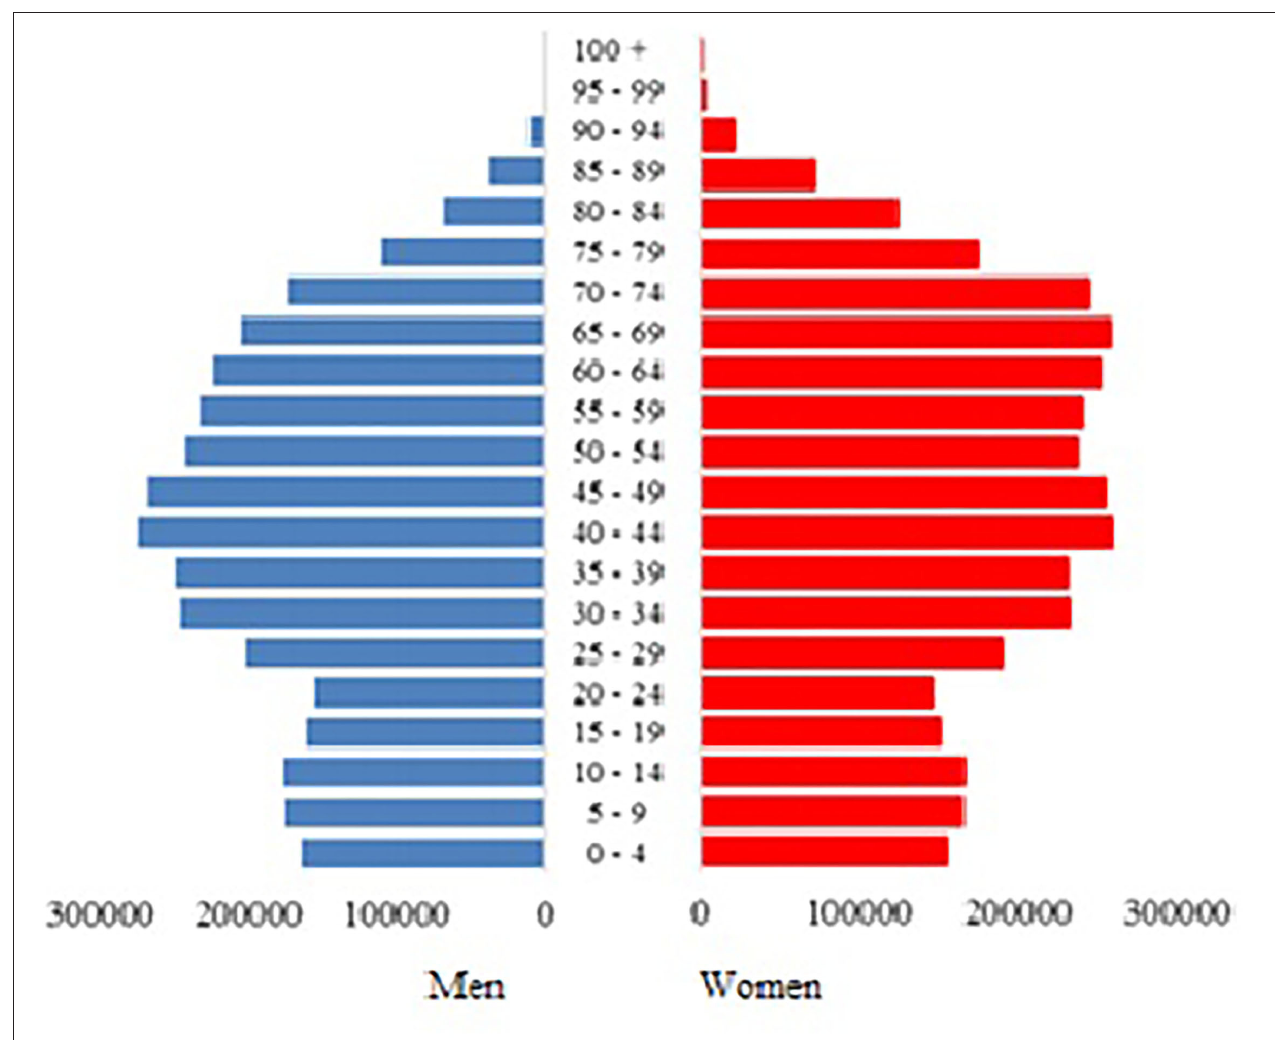
FIGURE 4 | Age distribution of the Bulgarian